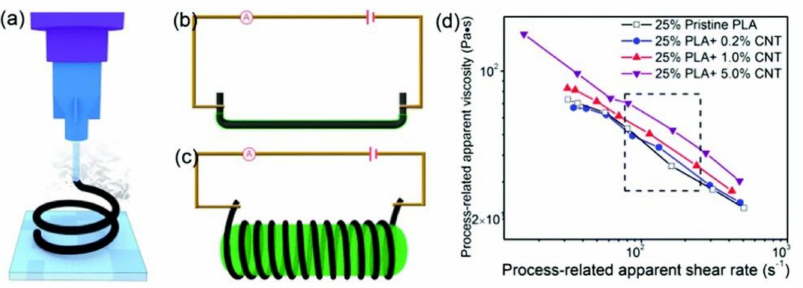
Figure 14. ( a ) Schematic representation of the solvent-cast 3D printing of nanocomposite microstruc- tures. Schematic circuits of the liquid sensing test for ( b ) the straight-line sensor and ( c ) the 3D helical sensor. ( d ) Process-related apparent viscosity of PLA nanocomposite solutions (typical pro- cessing window used in this work is shown by the dashed box) (Reproduced with permission from Reference [149], copyright 2015, The Royal Society of